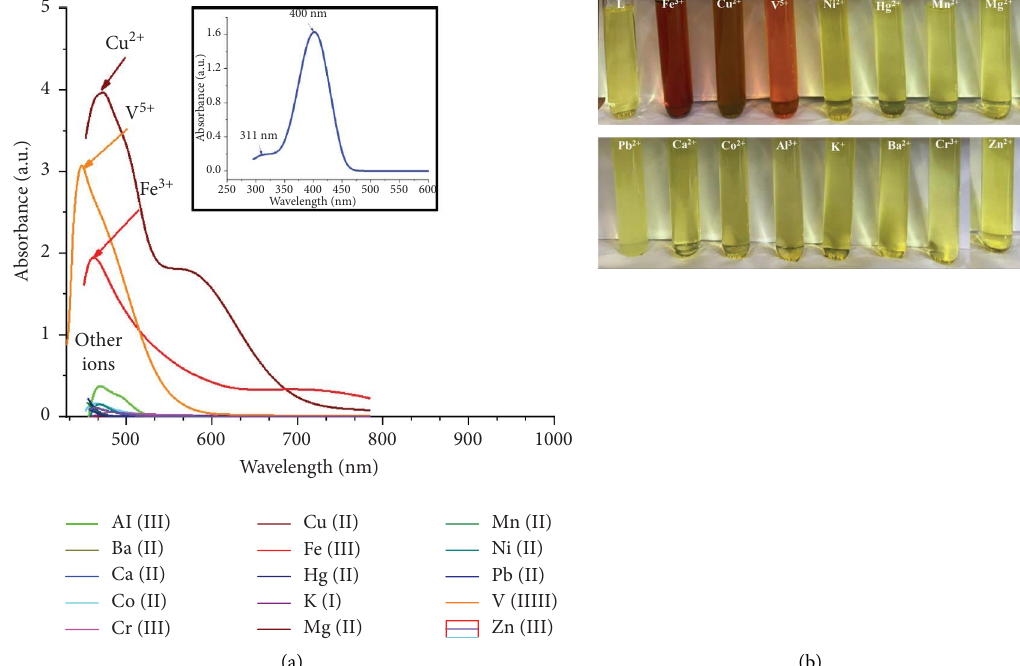
Figure 1: (a) UV–visible spectra of SL (1.0 × 10 − 3 M) in the presence of 1 equiv. of diferent metal ions (1.0 × 10 − 3 M) Cu 2+ , Cr 3+ , Fe 2+ Ni 2+ , Ca 2+ , Co 2+ , Mg 2+ , Zn 2+ , Fe 3+ , NH 4 VO 3 (V 5+ ), Mn 2+ , Hg 2+ , Pb 2+ , Ba 2+ , and Al 3+ , UV-vis. Absorption spectra of the free ligands SL (inset), (b) “naked eye” monitoring of color changes of SL (1.0 × 10 − 3 M) on adding 1 equiv. of diferent metal ions (1.0 × 10 − 3 M) Cu 2+ , Cr 3+ , Fe 2+ Ni 2+ , Ca 2+ , Co 2+ , Mg 2+ , Zn 2+ , Fe 3+ , NH 4 VO 3 (V 5+ ), Mn 2+ , Hg 2+ , Pb 2+ , Ba 2+ , and Al 3+ in ethanol-H 2 O solvent mixture (9:1, v/v).